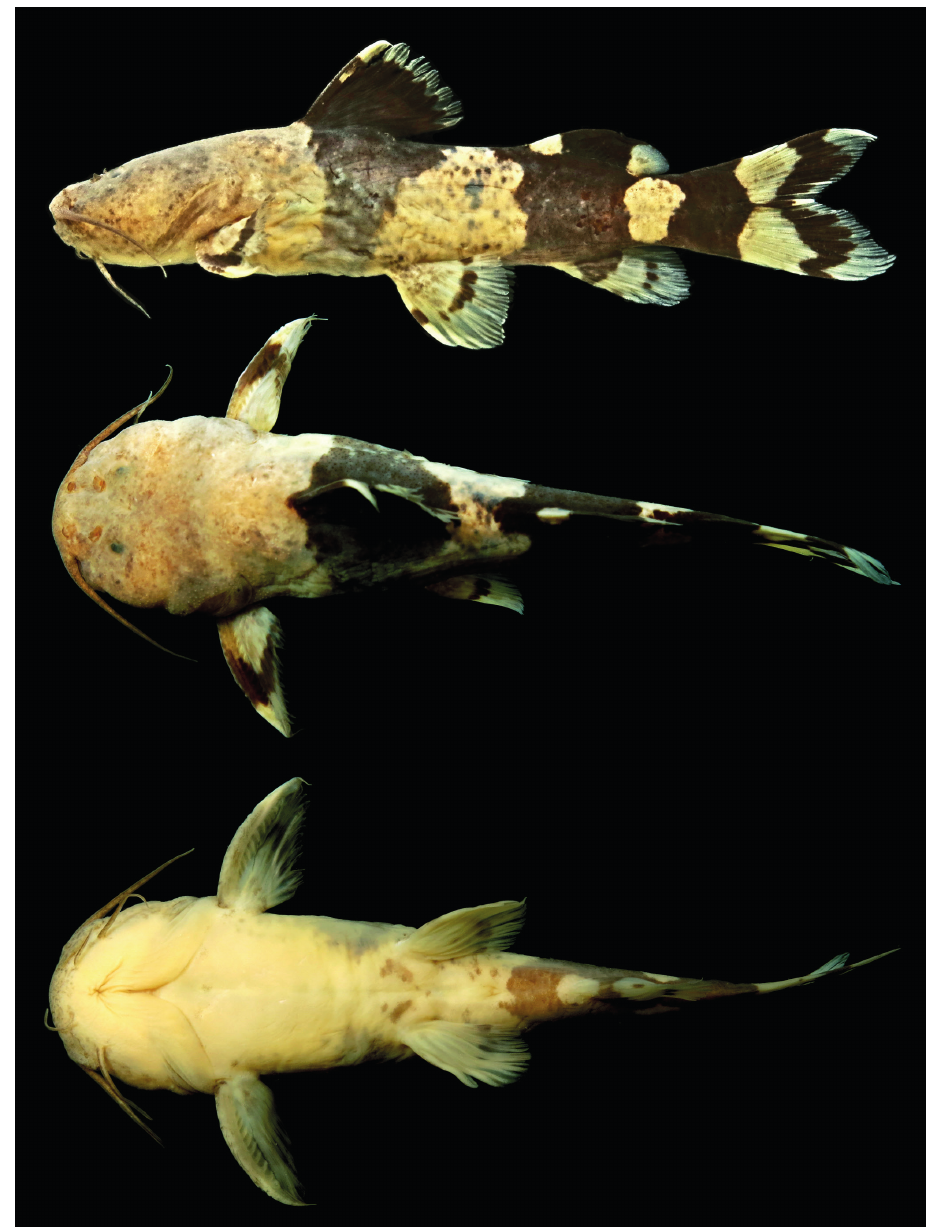
FIGURE 1 | Holotype of Rhyacoglanis varii , MZUEL 22317, 67.1 mm SL, rio do Peixe, upper rio Tocantins basin, Goianésia, state of Goiás,